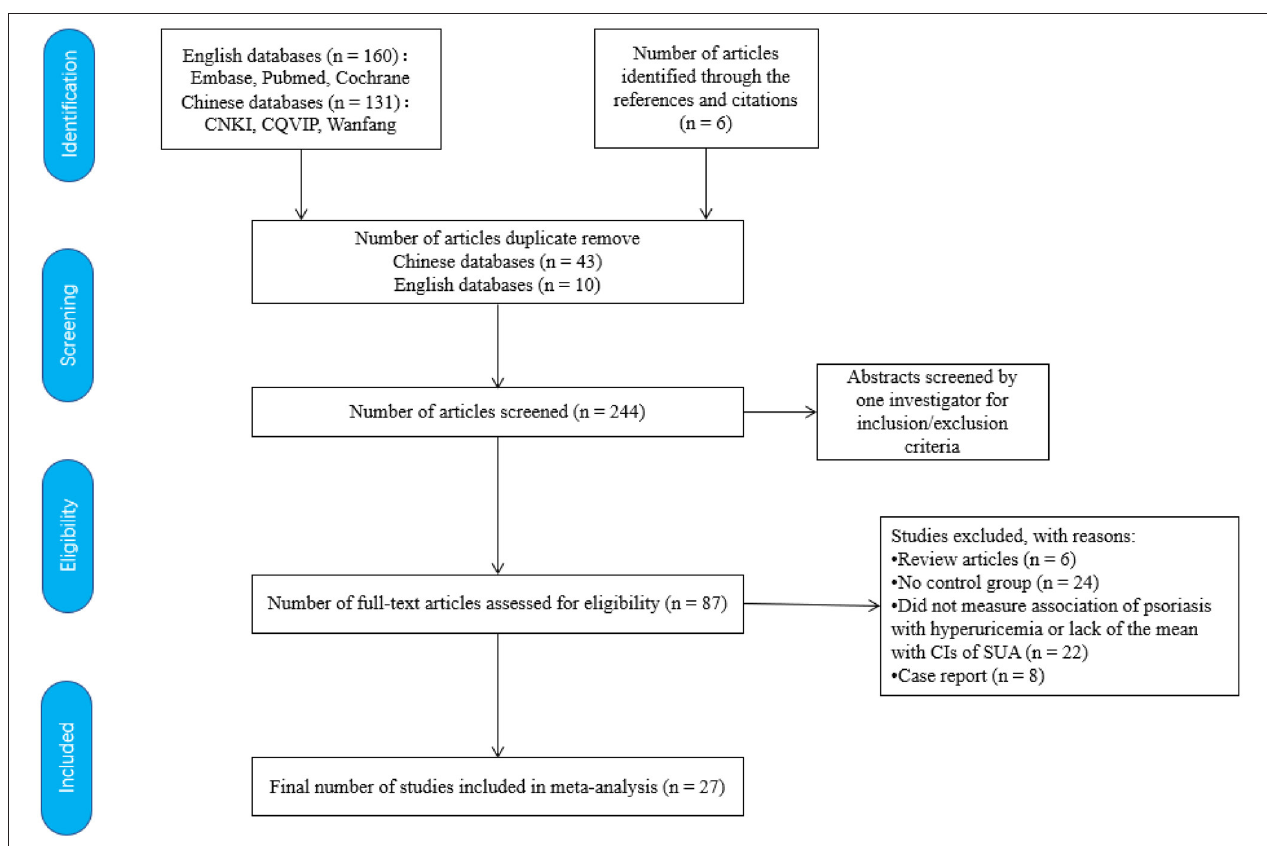
FIGURE 1 | Flowchart of literature search and study selection process. CNKI, the China National Knowledge Infrastructure database; CQVIP, the Chinese Scientific Journals Full Text Database; Wanfang, the Wanfang Data Knowledge Service Platform; CIs, confidence intervals; SUA, serum uric